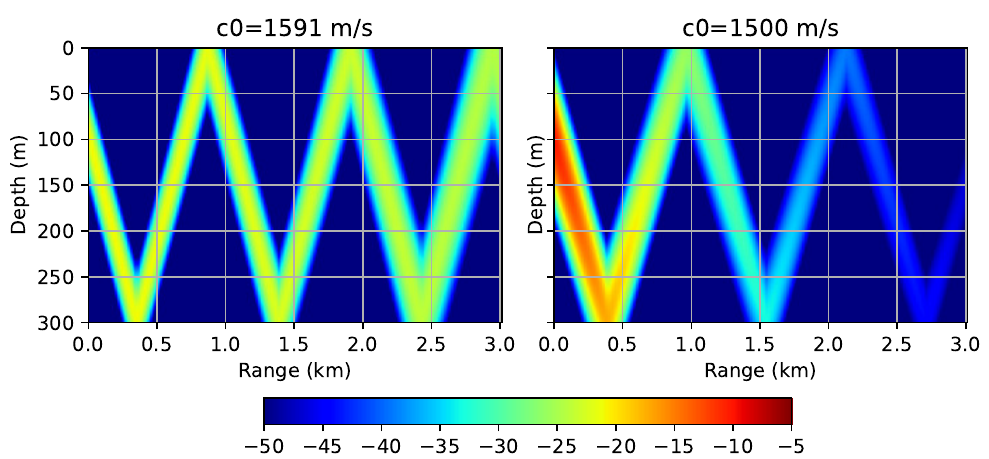
Figure 3. Waveguide with a perfectly reflective bottom. Acoustic pressure distribution (20log | ψ | ), computed on a grid with cells ∆ x = 24 m, ∆ z = 0.07 m using optimal c 0 = 1591 m/s ( left ) and suboptimal c 0 = 1500 m/s ( right ).